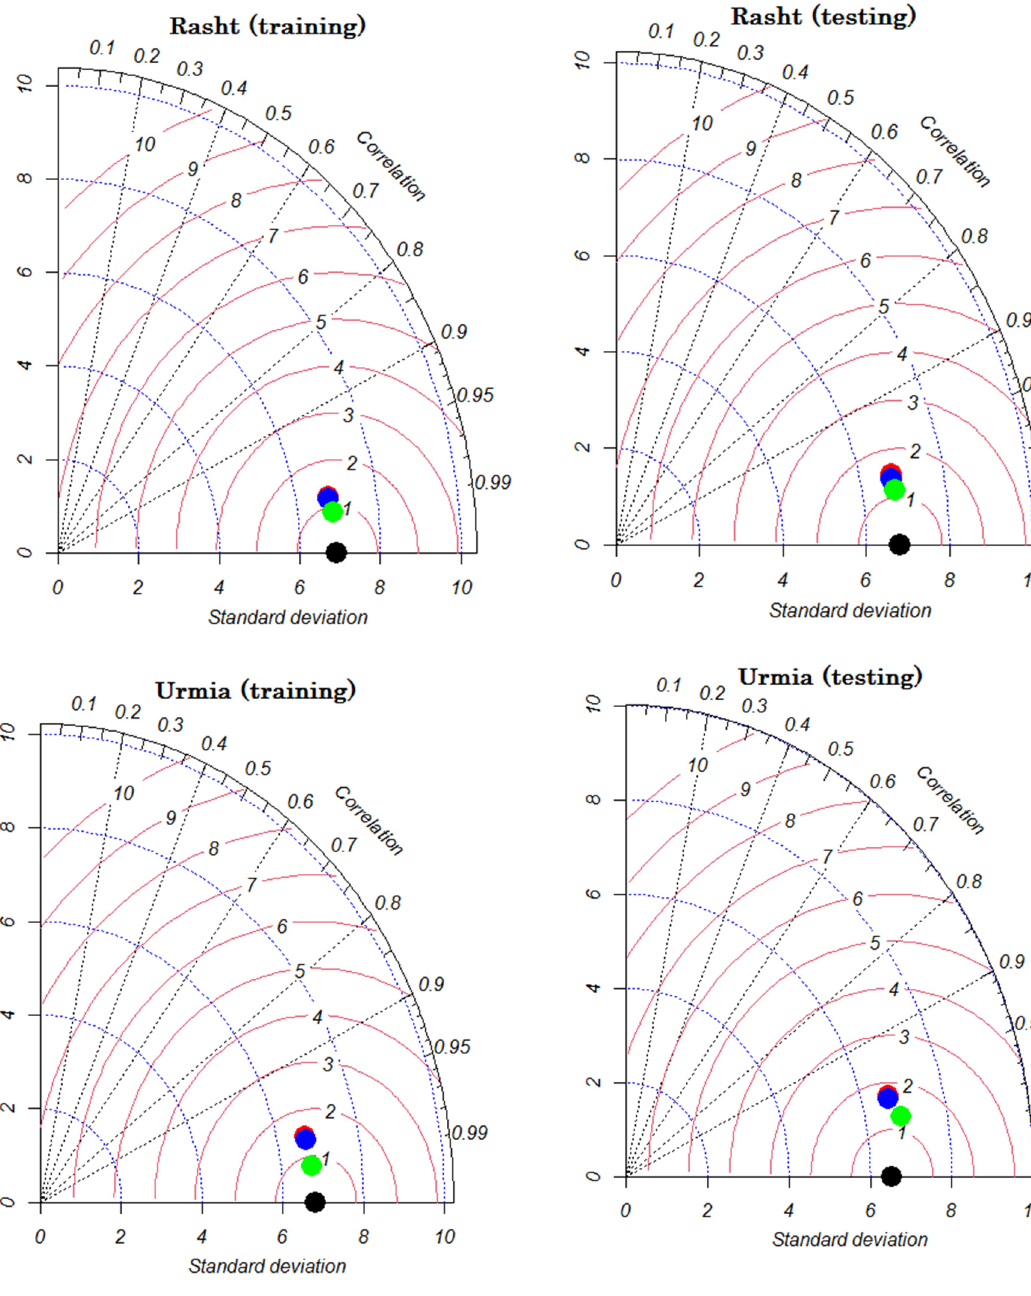
Figure 6. Taylor diagram of the measured and estimated Tdew through the best-performing classical and hybrid models at the Rasht and Urmia station during the training and testing periods (black point: measured values; green points: ANFIS9-DFA; red points: ANFIS9-BCO; blue points: ANFIS9).